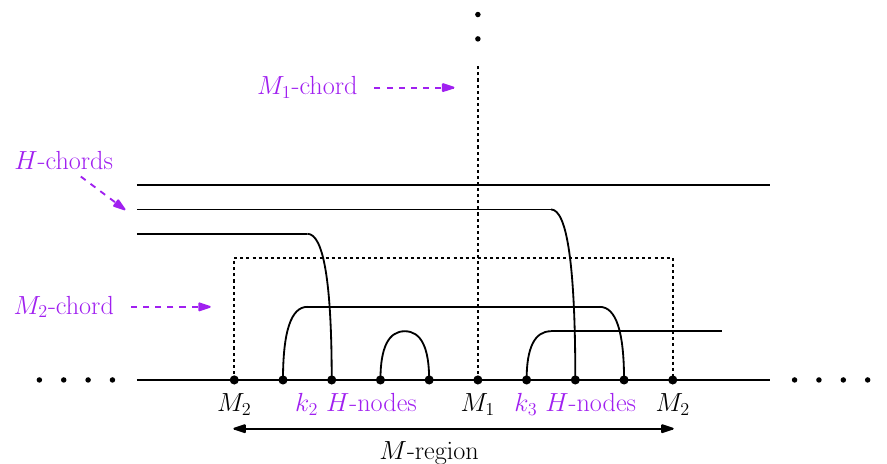
Figure 12. A subregion consisting of two M 2 nodes which are contracted, with another M 1 node between them. We will think of the M 1 -chord as being high enough, so that there are no H -chords above